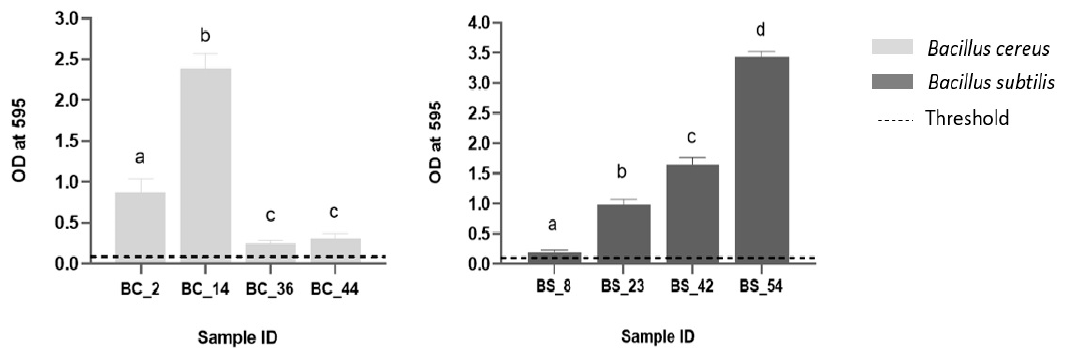
Figure 3. Biofilm formation of four selected B. cereus on the left, and four B. subtilis isolates on the right side. The OD threshold is reported as dotted line. Error bars indicate standard deviation. Different letters on the top of the bars indicated significant difference among the isolates, p < 0.05.